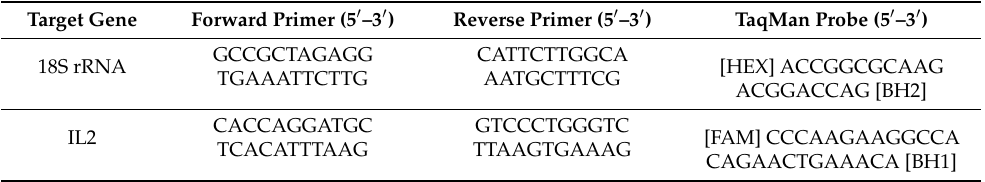
Table 1. Primer and probe sequences of related genes for quantitative polymerase chain reaction